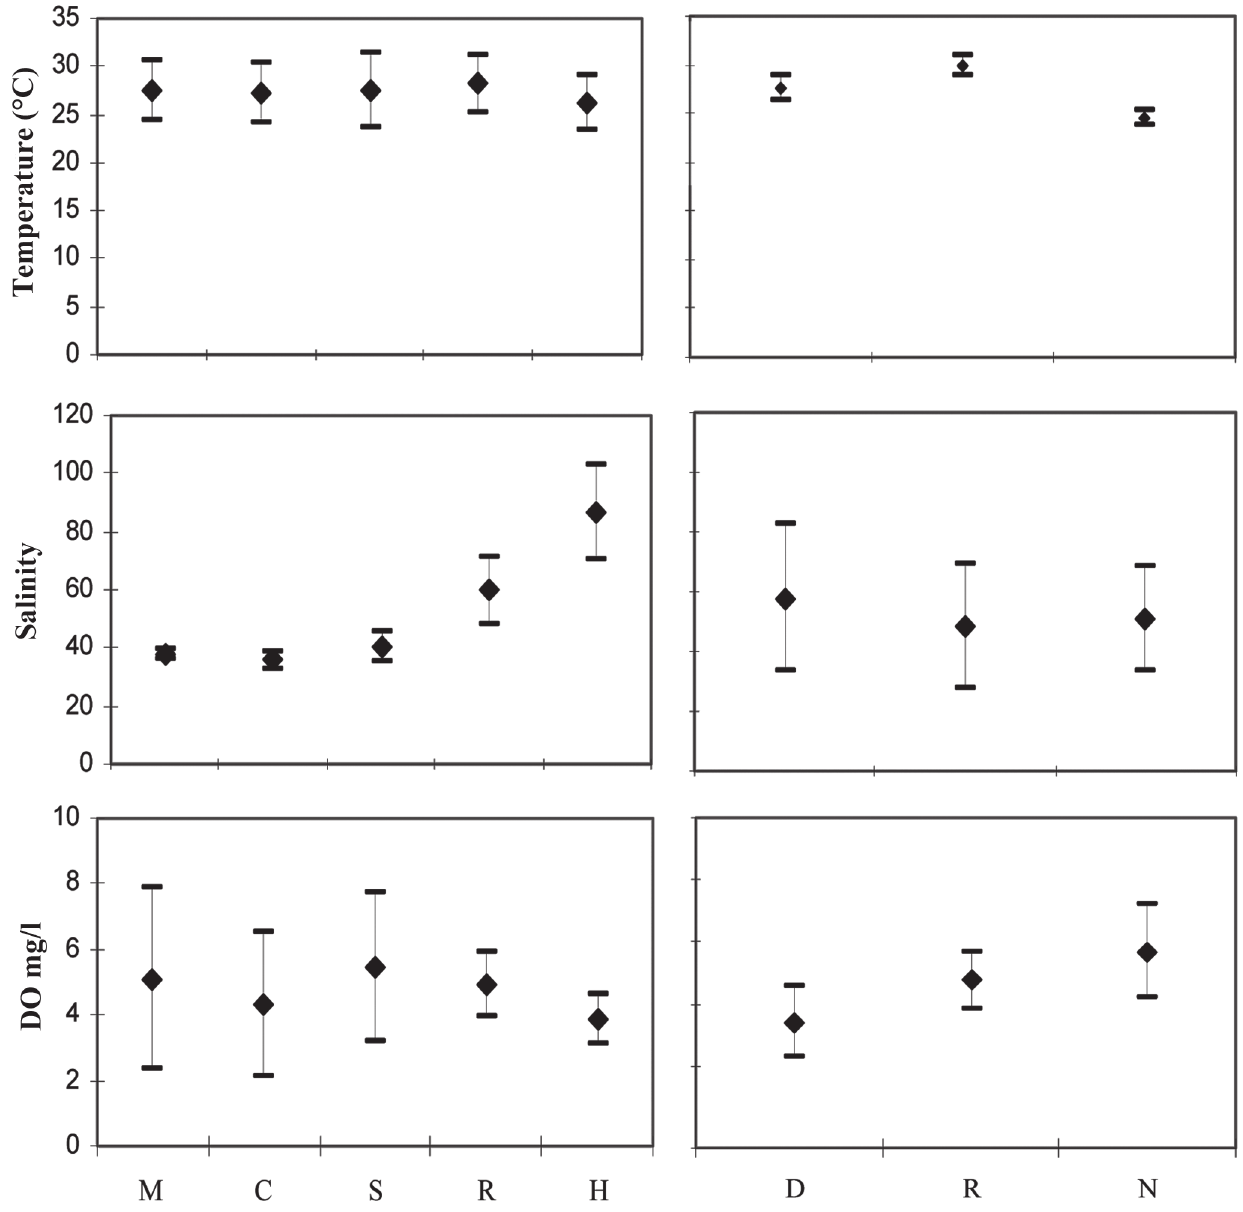
Fig. 2. Spatial (type of habitat) and seasonal variations in temperature, salinity, and dissolved oxygen (±1